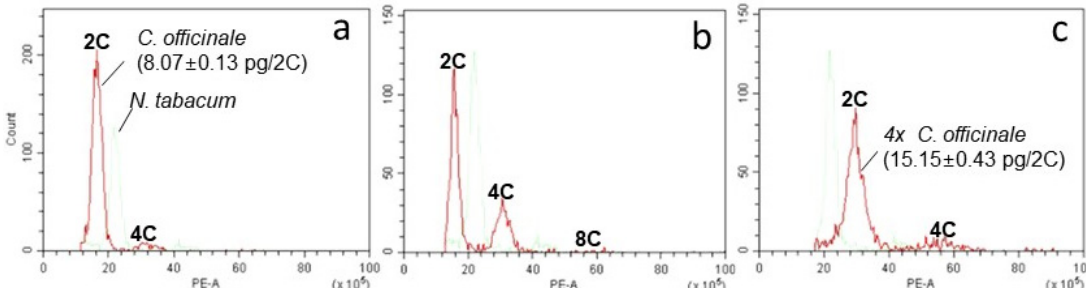
1 Data represent mean ± standard error (SE). Different lowercase letters indicate significant differences ( p < 0.05; Duncan’s multiple range test).